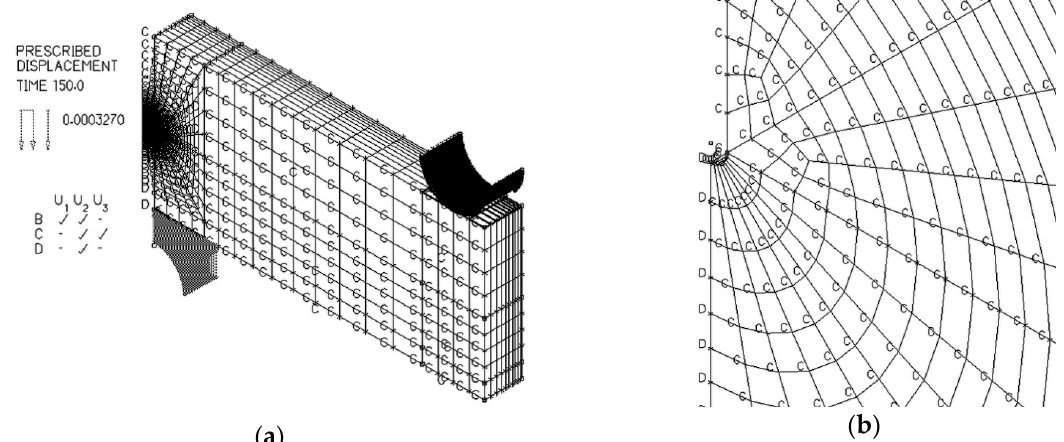
Figure 8. ( a ) The SENB specimen model and mesh used in numerical calculation; ( b ) crack tip zone details.